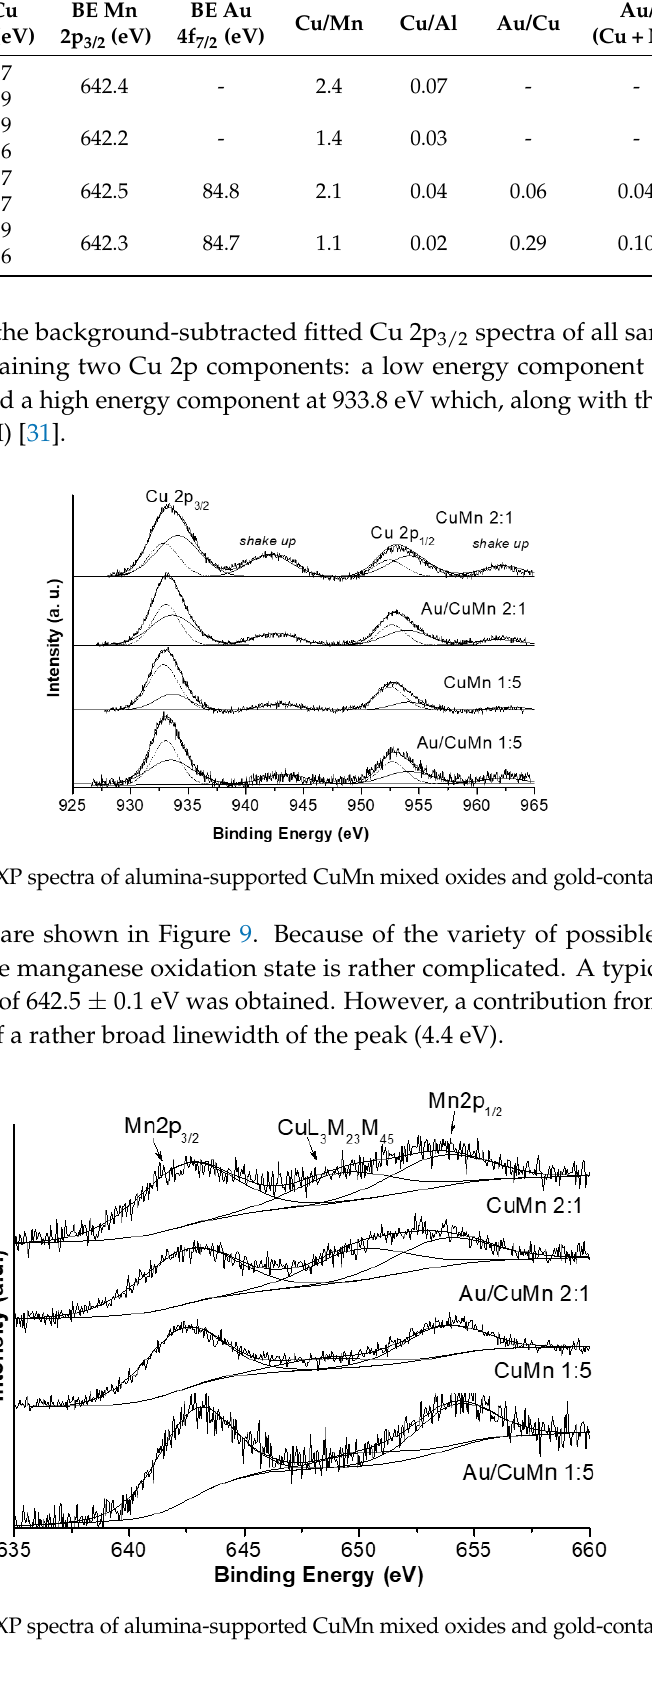
Table 3. X-ray photoelectron spectroscopy (XPS) data of the samples.